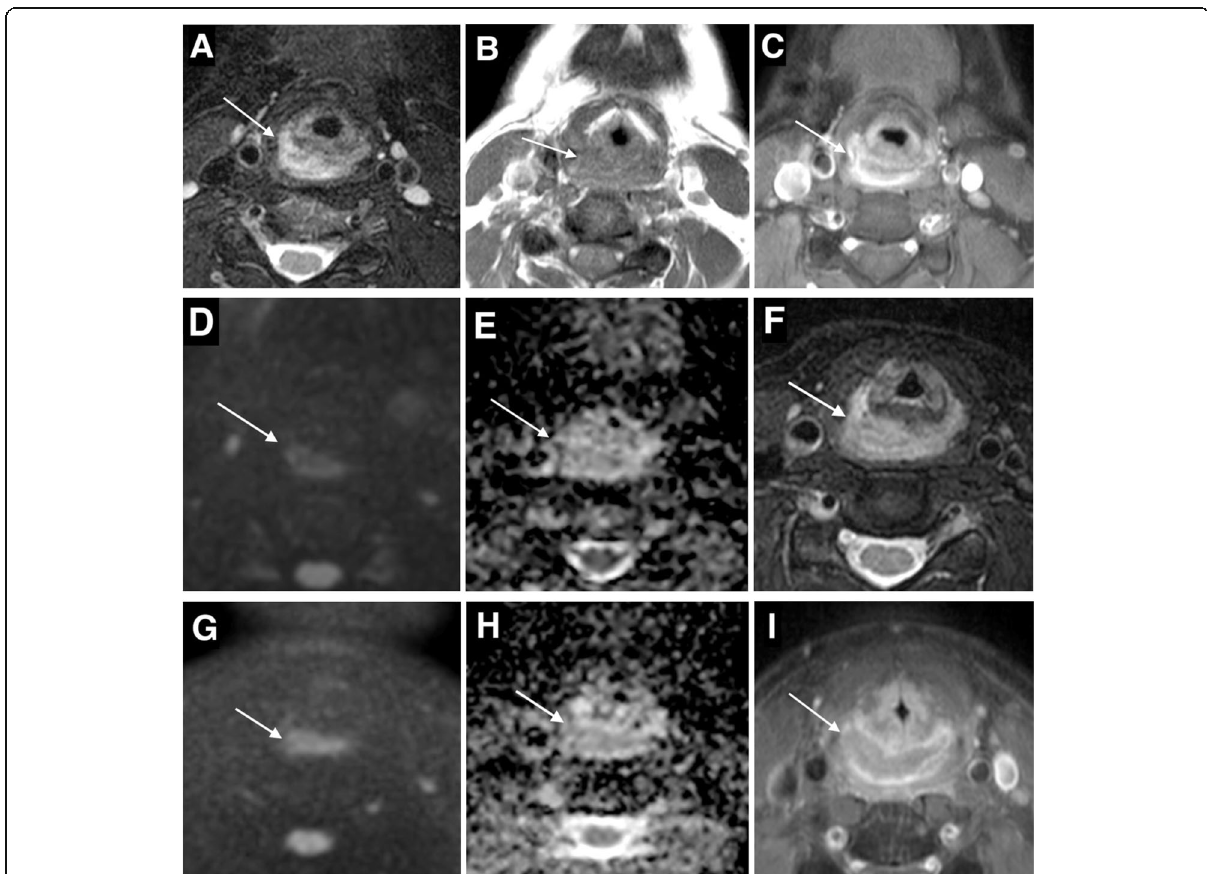
Fig. 4 A 39-year-old female patient with stage III hypopharyngeal SCC (T2N1M0) treated by concomitant chemoradiotherapy. a – e Axial pretreatment MR images. a T2WI with fat suppression, b non-contrast T1WI, c post-GAD T1WI with fat suppression, d b-1000 TSE-DWI, e the corresponding ADC map, all showed moderately hyperenhancing T2 hyperintense hypopharyngeal soft tissue mass involving the right pyriform sinus and postcricoid region, DWI shows high ADC (1.42 × 10 − 3 mm 2 /s). f – h Axial midtreatment MR images performed 3 weeks after start of chemoradiotherapy. f T2WI with fat suppression, g b-1000 TSE-DWI, h the corresponding ADC map, all showed